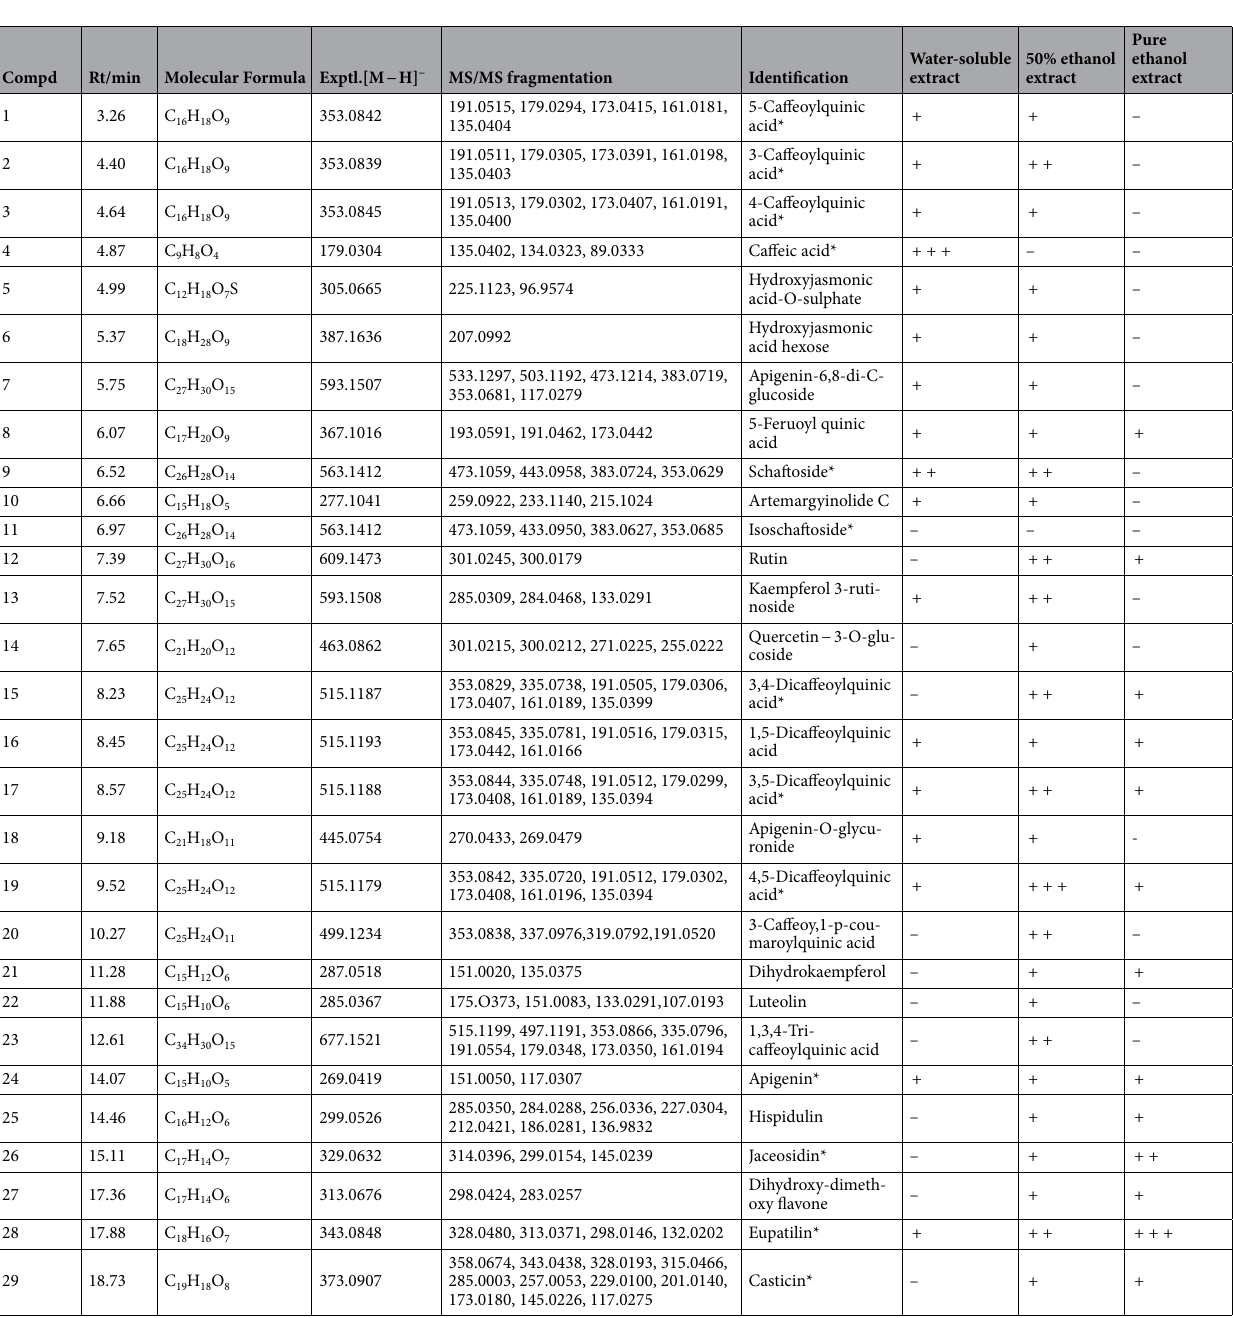
Table 1. The chemical composition of different solvent extracts of A. argyi. “ + + + , + + , + ” means that the relative content is from high to low, “–”means very low content; Compd. was the compound number; Rt represtented retention time; Exptl. [M-H]- was experimental m/z of molecular ions in the negative ionisation mode; *Compound was positively identified by comparing the retention time, high-resolution molecular ions and fragment ions with the authentic standards. The mass spectrometry data such as total ion chromatograms, molecular ion peaks and secondary fragment ions were collected by Masslynx 4.1 software and processed with ProGenesis QI V2.0 (Waters Corp., Milford,